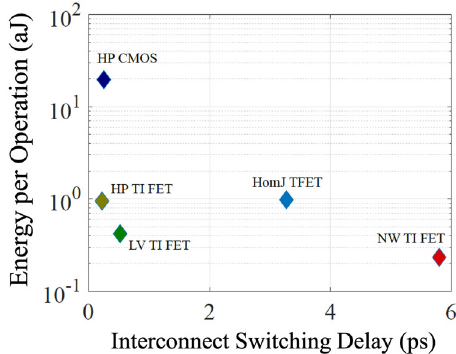
Fig. 2 Benchmarking topological fi eld effect transistors. Comparison of the experimental (TIFET) and theoretical low-voltage (LV) and high- performance (HP) approaches 36 to the design of a FET based on the use of topological materials with other established competing FET technologies, such as the homojunction tunnel FET (homJTFET) and current high- performance CMOS technologies (HP CMOS). The comparison is based on the amount of energy that is dissipated per operation for each technology plotted against the interconnect delay in current CMOS technology. The approach utilized here follows the methodology in refs. 42,43 . We conclude that, while there are many areas that may be improved to increase the performance of topological materials in FET technologies, they are not currently a competitive alternative to CMOS. Nonetheless, theoretical estimates demonstrate that topological transistors have suf fi cient promise to offer marked increases in performance at reduced power consumption when compared to current FET